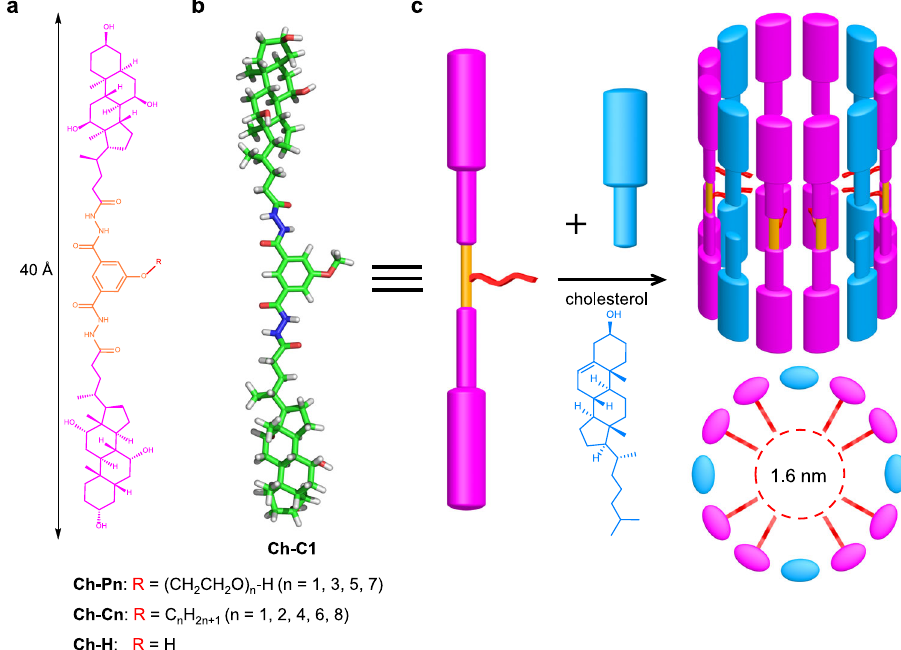
Fig. 1 | Molecular design and self-assemblyofnanopores.a Chemical structures of cholic acid-derived amphiphilic transmembrane channels Ch-Pn , Ch-Cn and Ch-H . b Computationally optimized structure of Ch-C1 at the level of B3LYP/6-31G* in the gas phase. c Schematic illustration of one possible means to